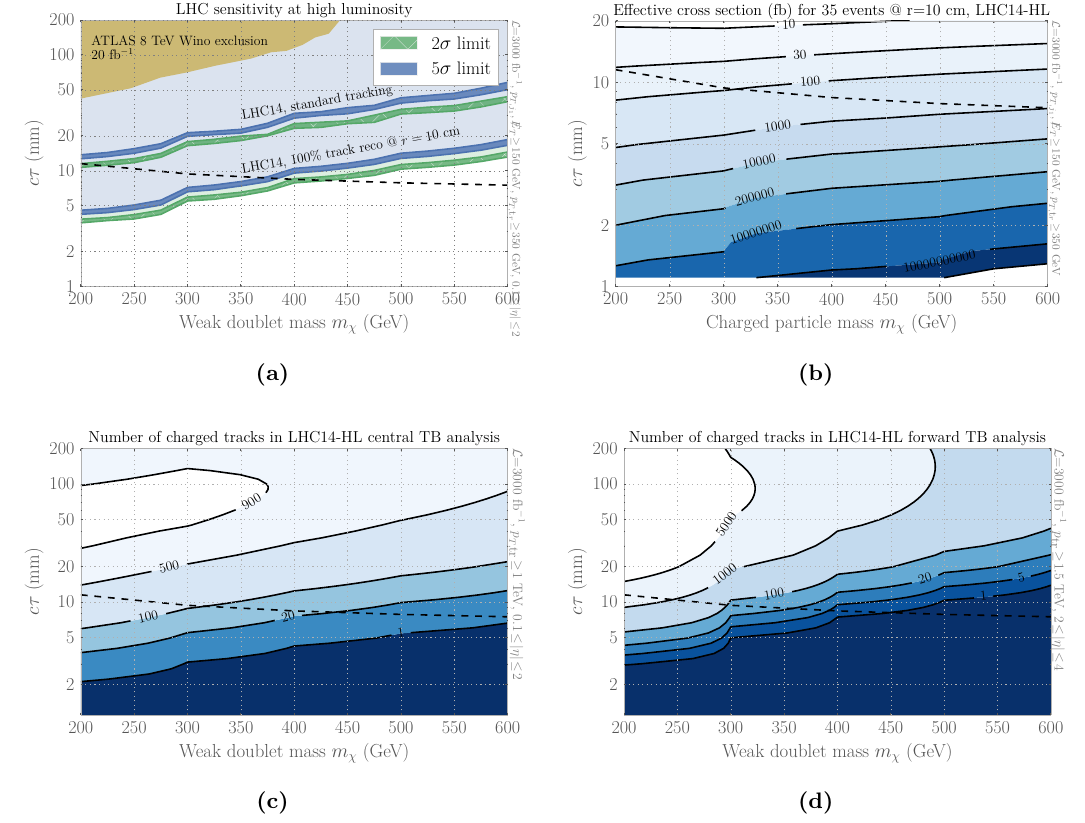
Figure 9. Reach for a high-luminosity run of LHC14, with = 3000 fb (cid:0) 1 integrated luminosity L in (a) conventional analysis with and without (speci(cid:12)ed) improvements in tracker granularity close to the beamline. We assume 50% background systematics , with estimated uncertainties (details in text) in the 5 (cid:27) exclusion (2 (cid:27) discovery) contours shaded in blue (green). The yellow shaded region corresponds to the ATLAS 8 TeV limit for pure Wino states. (b) E(cid:11)ective cross section (de(cid:12)ned in text) required for 35 charged-track events in conventional analysis at LHC14-HL, corresponding to a (conservative) 5 (cid:27) discovery reach. (c) Number of disappearing charged tracks satisfying selection criteria in central TB analysis. (d) Number of disappearing charged tracks satisfying selection criteria in forward TB analysis. The dashed line corresponds to the nominal decay length for pure-Higgsino